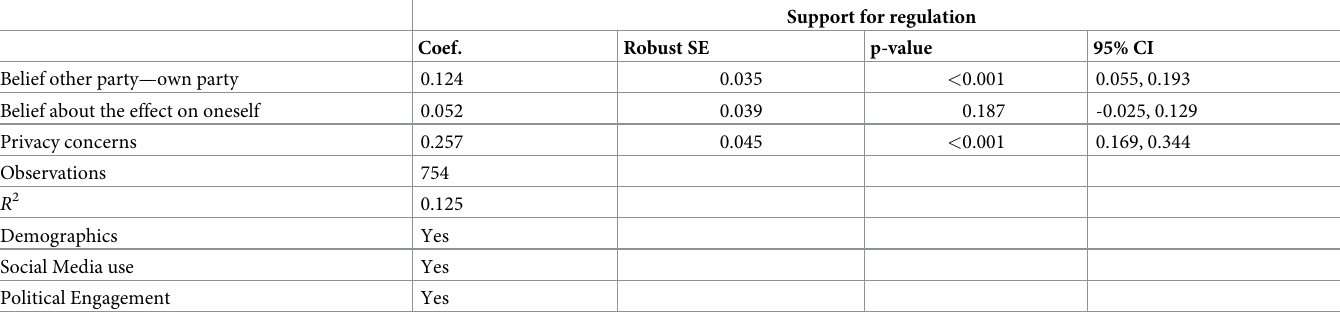
Table 2. Regression of determinants predicting the willingness to support stricter regulation of online targeted political advertising, control